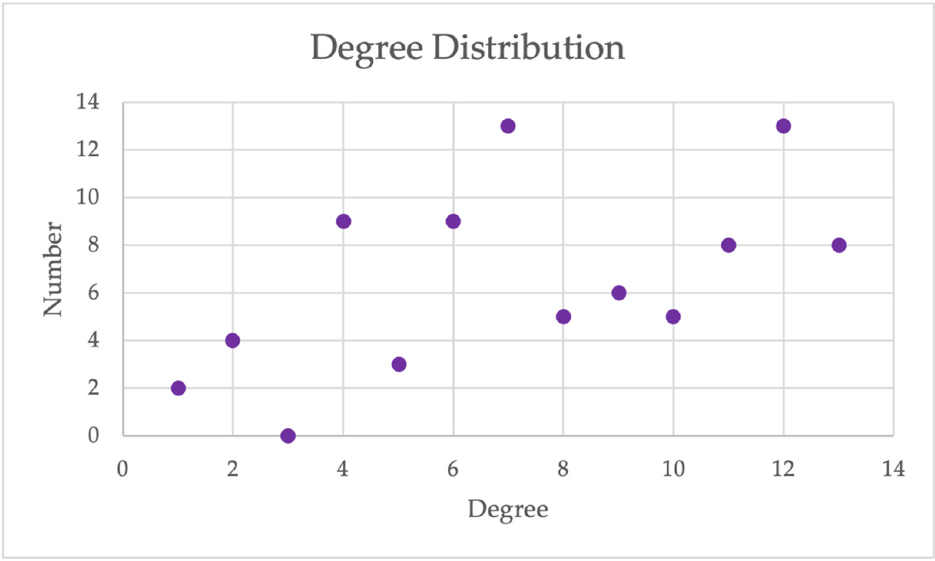
Figure 3. The probability distribution of the degree of a node in an HEA network is the distribution of connections it has to other nodes which is called degree distribution.